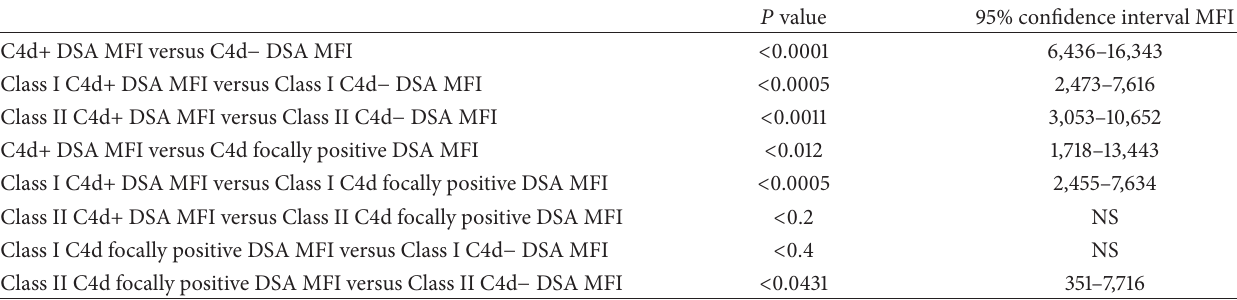
Table 6: In depth analysis of DSA and C4d+, C4d focally positive, and C4d − patient